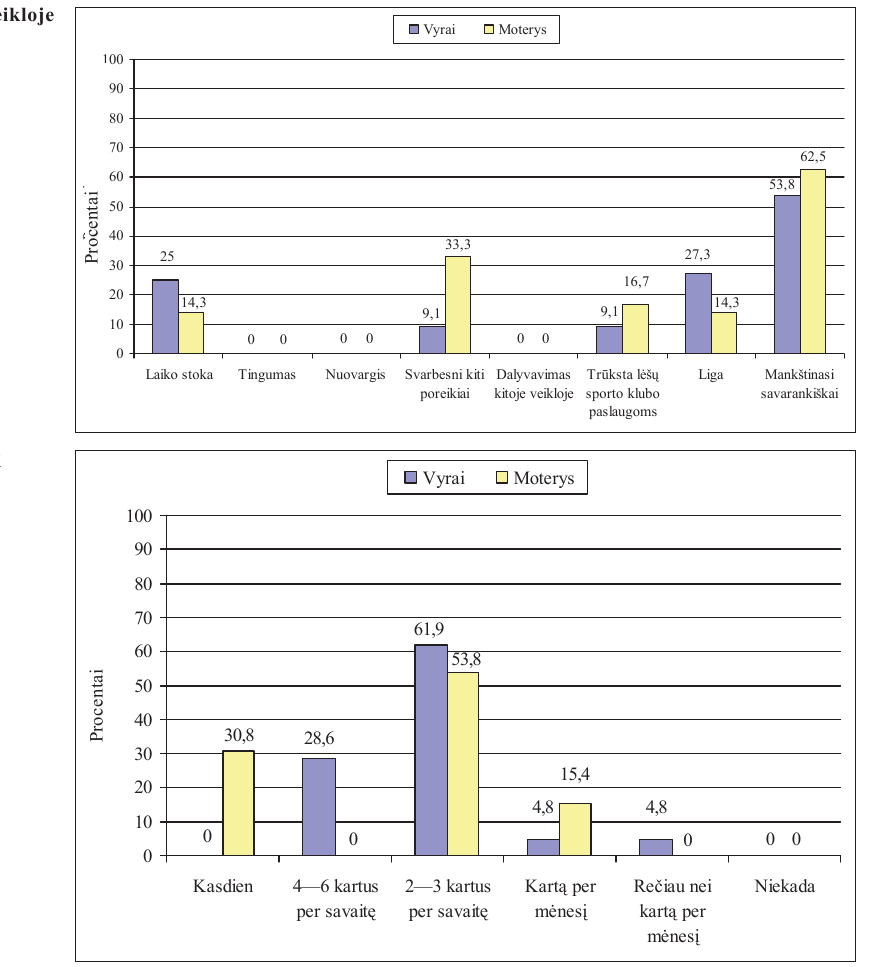
3 pav. Mankštinimosi savarankiškai dažnis